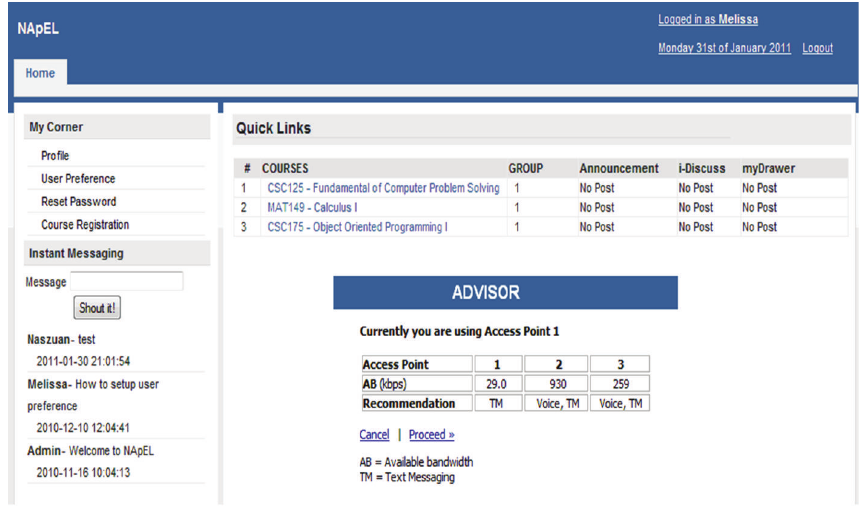
Figure 4: NApEL provides a mechanism for detecting insu ffi cient bandwidth and providing recommendation on suitable communication tools to be used based on available